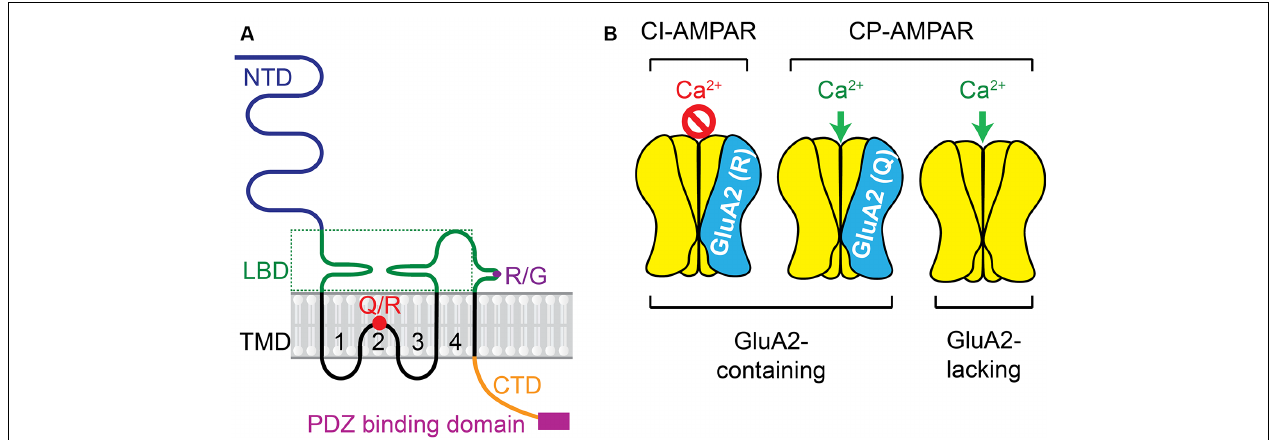
FIGURE 1 | AMPAR subunit and the receptor complex. (A) Each subunit has four domains including: (1) the large N-terminal extracellular domain (NTD); (2) the highly conserved extracellular clamshell-like ligand-binding domain (LBD) and (3) transmembrane domains (TMD) 1–4, among which the TMD2 is a re-entry or hairpin loop that forms the pore-lining region and responsible for the channel properties of the receptor, (4) the C-terminal intracellular domain (CTD). Two pre-mRNA editing sites, Q/R and R/G, are presented. More details about Q/R editing are in Figure 3 . (B) Ca 2+ permeability of AMPAR complex varies depending on the presence of the GluA2 subunit in the tetrameric complex and the presence of the positively charged R residue in the GluA2-containing AMPARs.